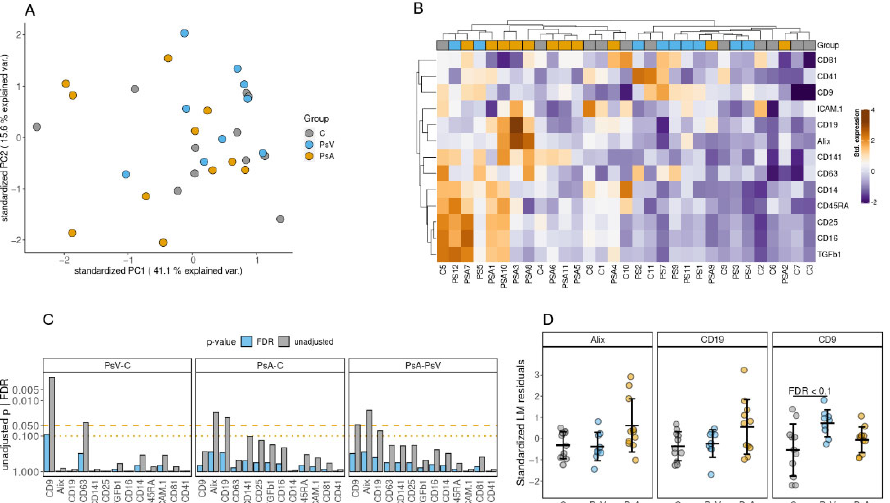
Figure 2. EV Array phenotyping for blood serum EVs. ( A ) The first two principal components calculated from 13 markers considered to be uniformly detected on the surface EVs in at least one of the patient groups. ( B ) Heatmap and hierarchical clustering (Euclidean distance) of linear model residuals resulting from models with patient age and storage time of serum samples as predictors and abundance of the surface marker as the response variable. ( C ) Statistical significances of the